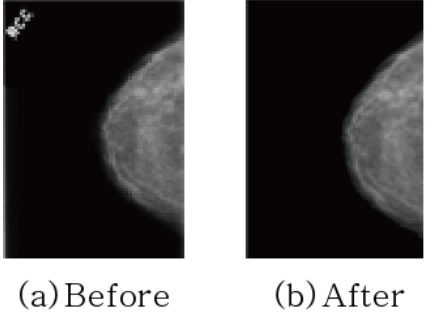
Figure 4. Removing texts in mammography.